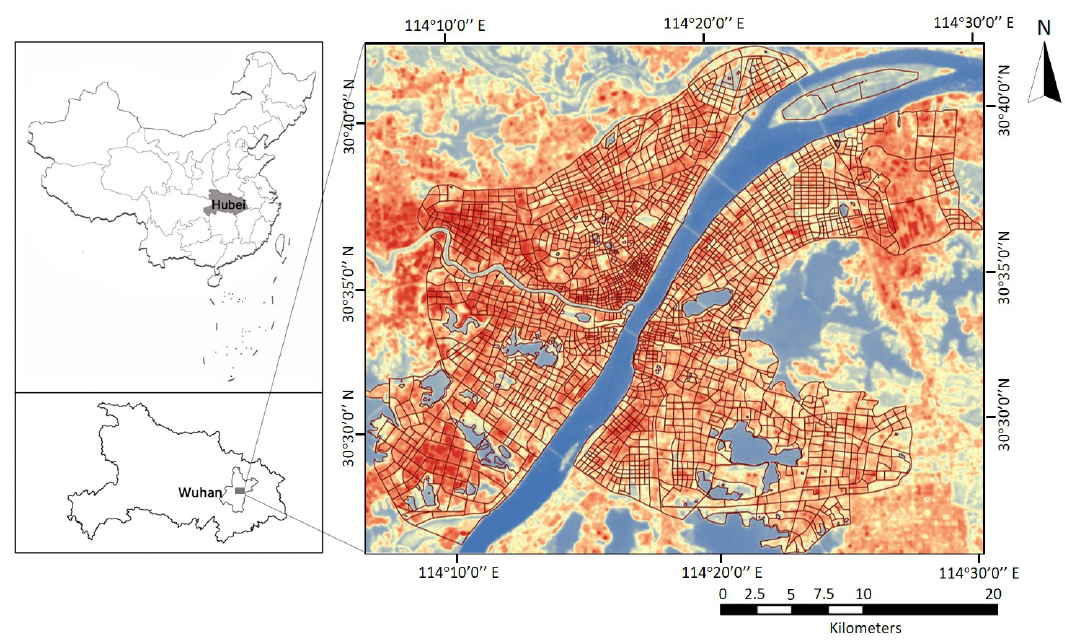
Figure 1. The study area represented by the land surface temperature image retrieved by Landsat 8 image (RGB) acquired on 16 August